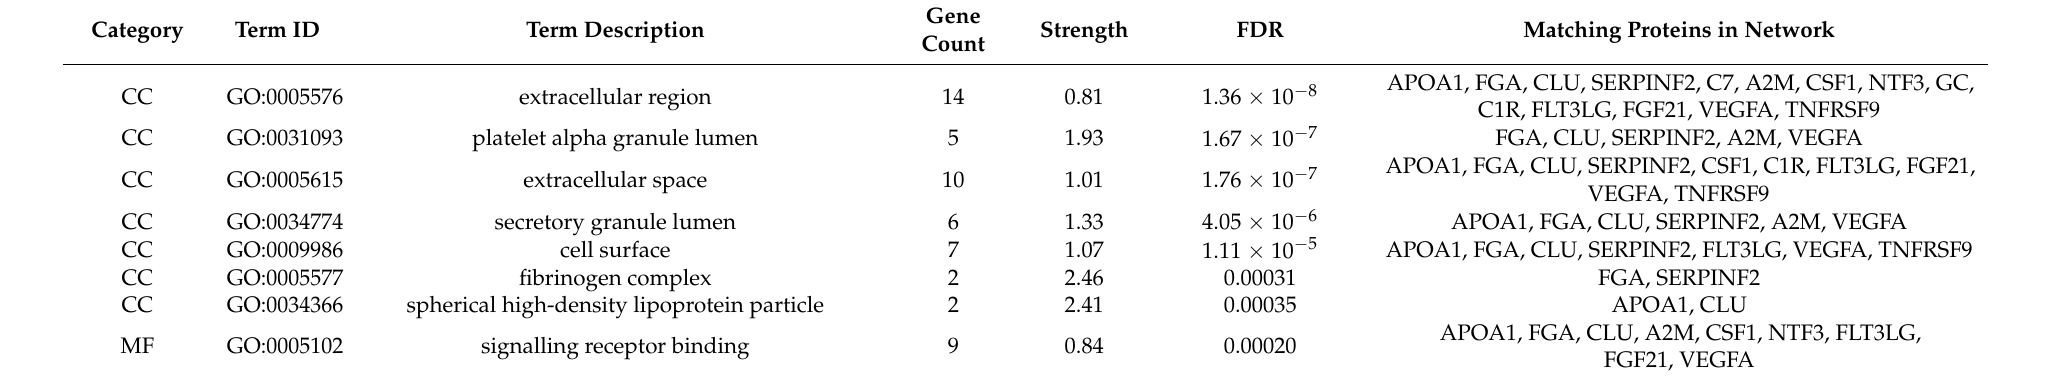
Table 9. The most significant GO terms within cellular component (CC), molecular function (MF), and biological process (BP) for HPT in